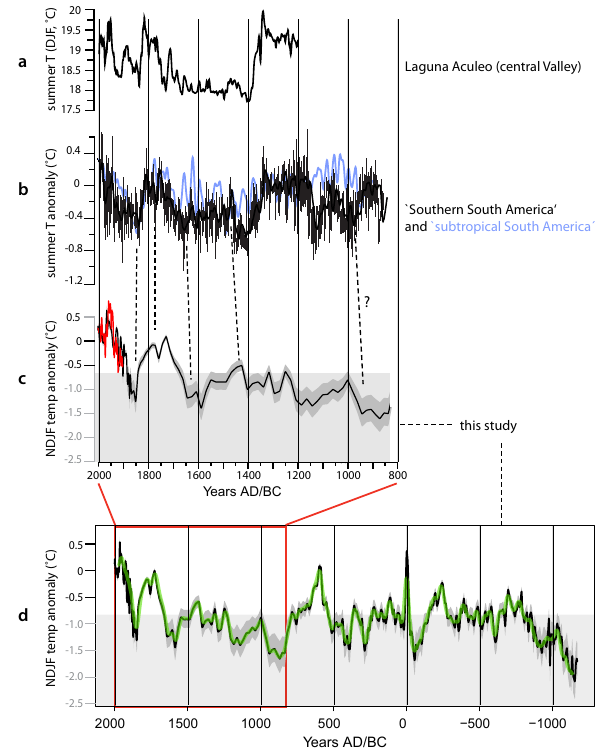
Fig. 5. Comparison of the few available summer temperature re- constructions for this region, showing (a) DJF temperatures recon- structed from spectral reflectance indices measured on a sediment core from Laguna Aculeo (Central Valley, 34 ◦ S, 515ma.s.l.; Von Gunten et al., 2009b), (b) DJF temperature anomalies for southern South America, which was based on climate field reconstructions using a range of meteorological, documentary and proxy data, in- cluding the record shown in (a) (Neukom et al., 2011). The blue line in (b) shows the regional reconstruction from the same authors for subtropical South America. The NDJF temperature reconstruc- tion (black line) from Laguna Chepical back to AD800 is shown in (c) together with the bootstrapped model errors (grey envelope). The reanalysis NDJF temperatures are shown in red (Mitchell and Jones, 2005). In (d) the full reconstruction is shown, together with the 50yr-filtered data (green line). Because of the absolute temper- ature offset between the reanalysis and meteorological data at this location (compare y axes in Fig. 4a and b, and see Fig. 1b), the final reconstruction was calculated as temperature anomalies (in ◦ C) in comparison to the 19th century mean. The grey shaded bars in (c) and (d) indicate reconstructed temperature values that lie outside the temperature range of the calibration period, implying that these data should be interpreted in a qualitative manner only.